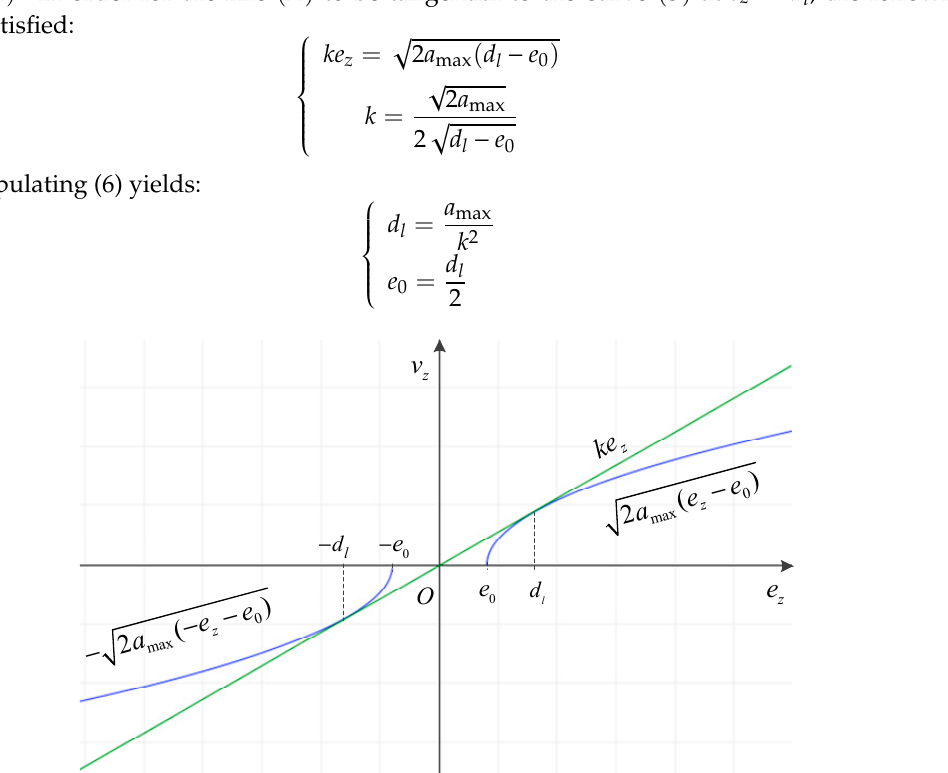
Figure 4. Graphical illustration of the curve ( ) S (blue), the line ( ) Δ (green), and their relations.